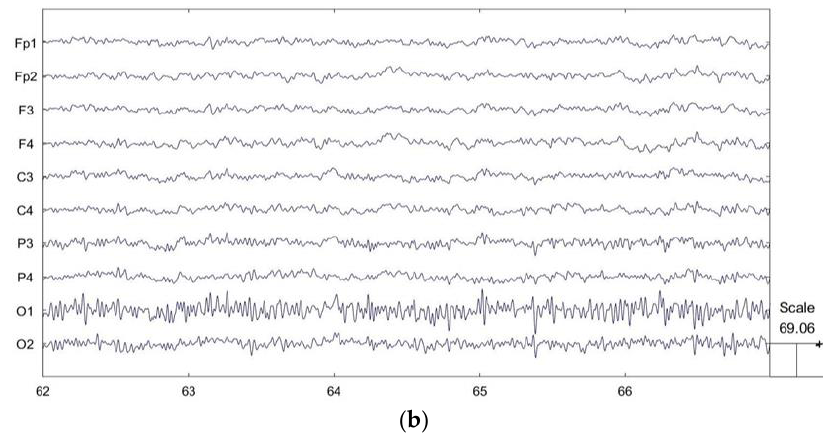
Figure 4. ( a ) EEG signal waveform fragments before preprocessing. There are obvious electrooculogram artifacts at around 63 s. ( b ) EEG signal waveform fragments after preprocessing. The eye movement artifacts are removed and the signal waveforms are stable and smooth.